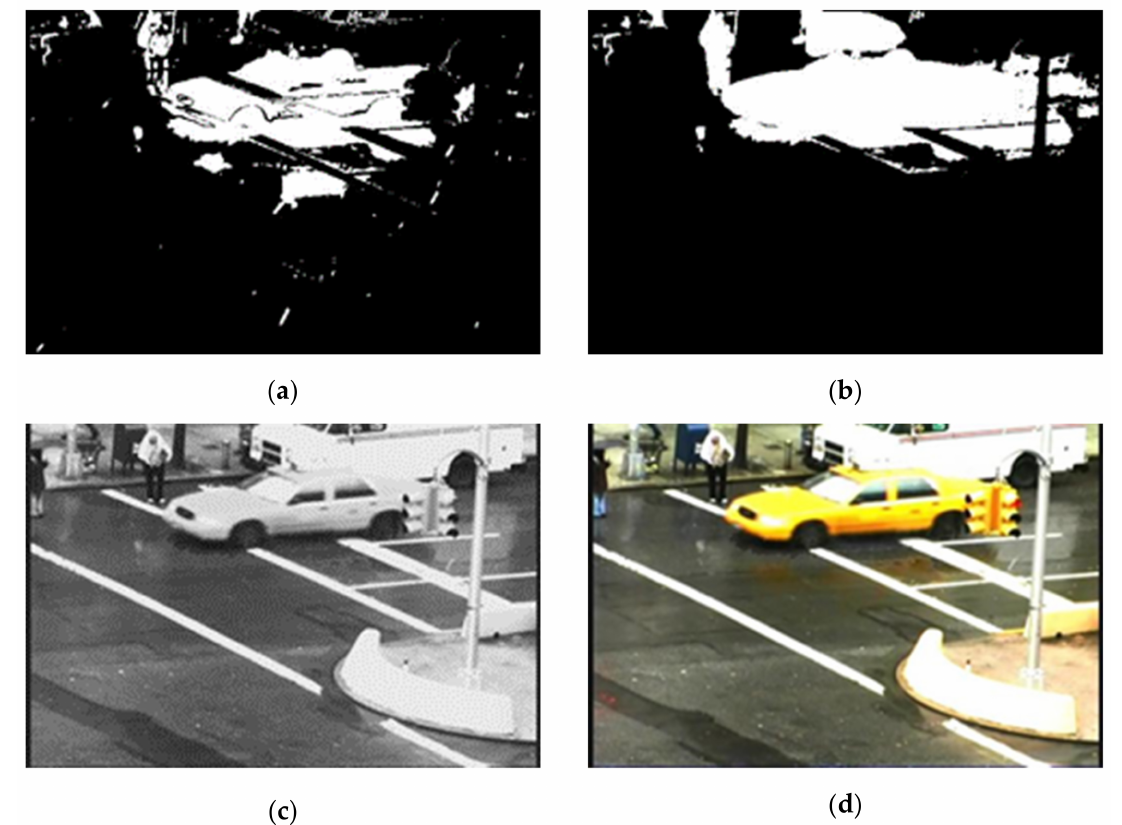
Figure 11. Results after fusing data of the binary foreground and the predicted object mask of previous step for the video sequence “Traffic” frame 79. ( a ) Binary Foreground ( b ) Final object mask ( c ) Generated rain-free frame and ( d ) Final rain-free